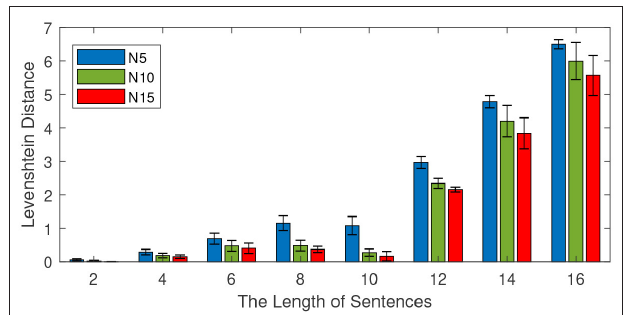
FIGURE 8 | Effect of the length of sentences on retrieval performance. The total number of sentences is 100, the number of neurons in each column is 5, 10, and 15. The length of sentences varies from 2 to 16 with an interval of 2, and the length of the input is half of the training length.